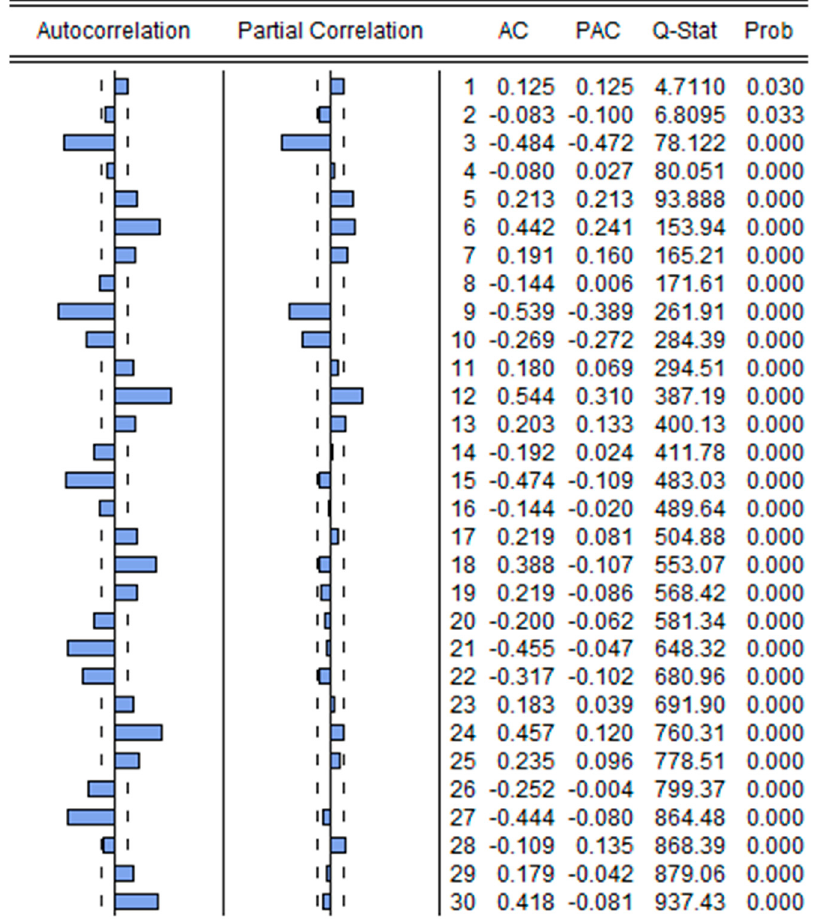
Figure 4. Residuals of designated model through plotting ACF and PACF.